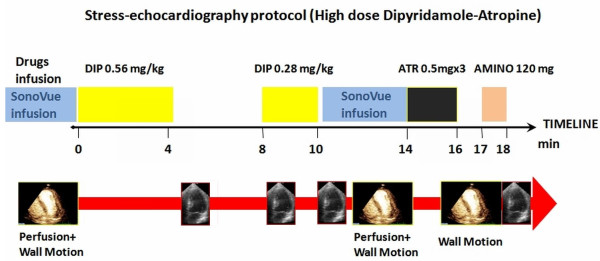
Stress echocardiography protocol. Abbreviations as in table 1.